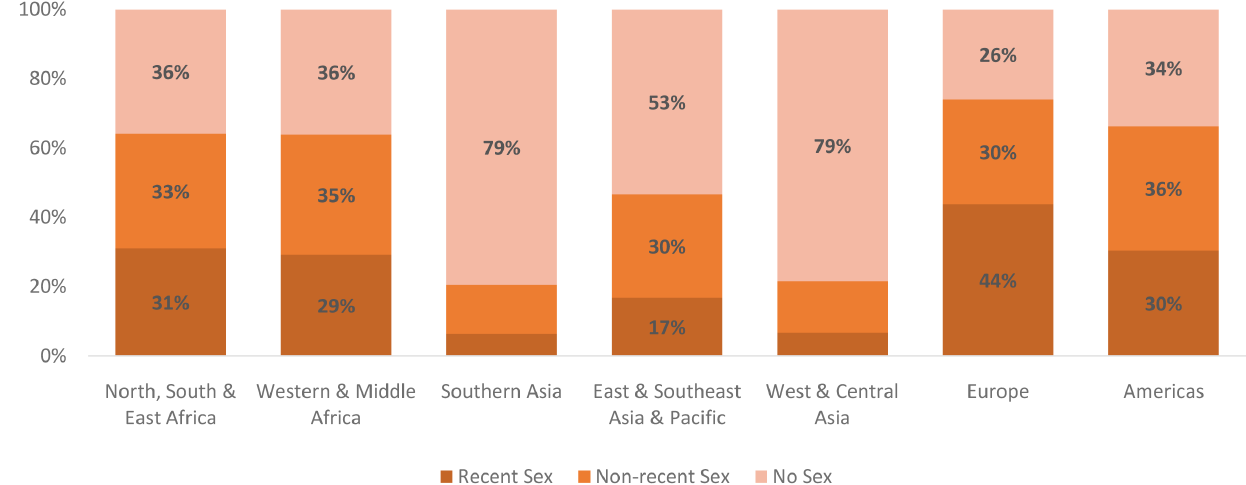
Figure 9. Distribution of never-married women by market segment and region in 2040. This figure shows the distribution of never- married women across the three never-married segments in 2040 by region. There is wide regional variation, especially in the share of never married women who have never had